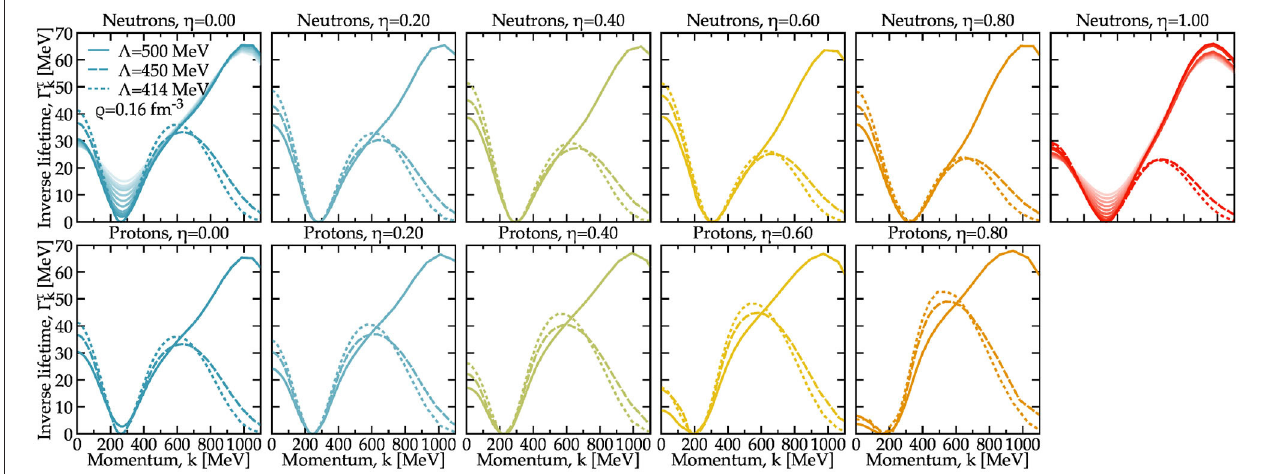
FIGURE 10 | Neutron (top) and proton (bottom) inverse single-particle lifetimes as a function of the momentum. For details, see the caption of Figure 9